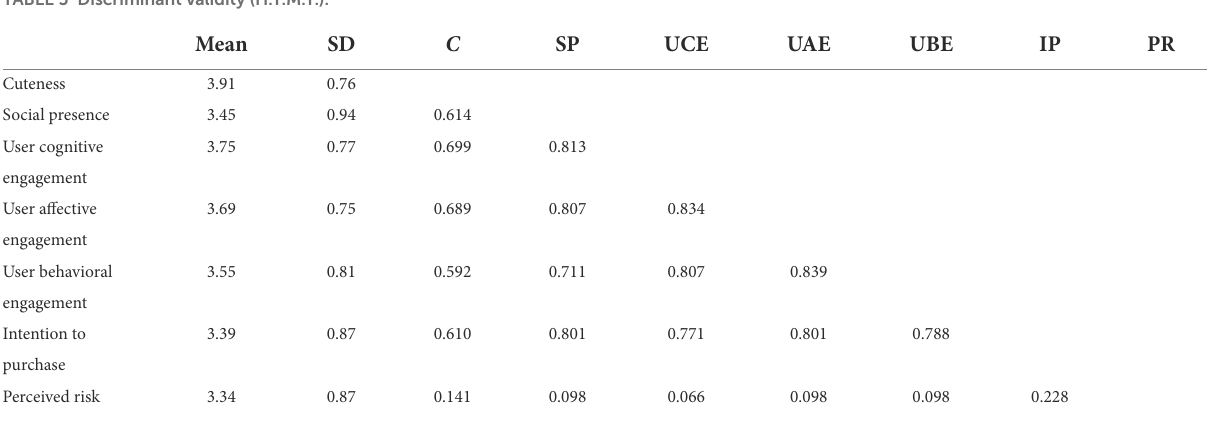
TABLE 5 Discriminant validity